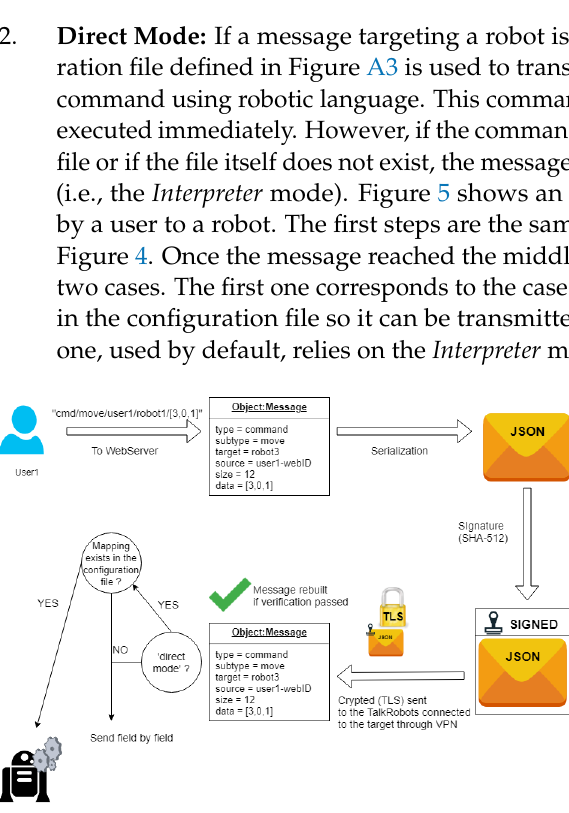
Figure 4. Information transmission (field by field).